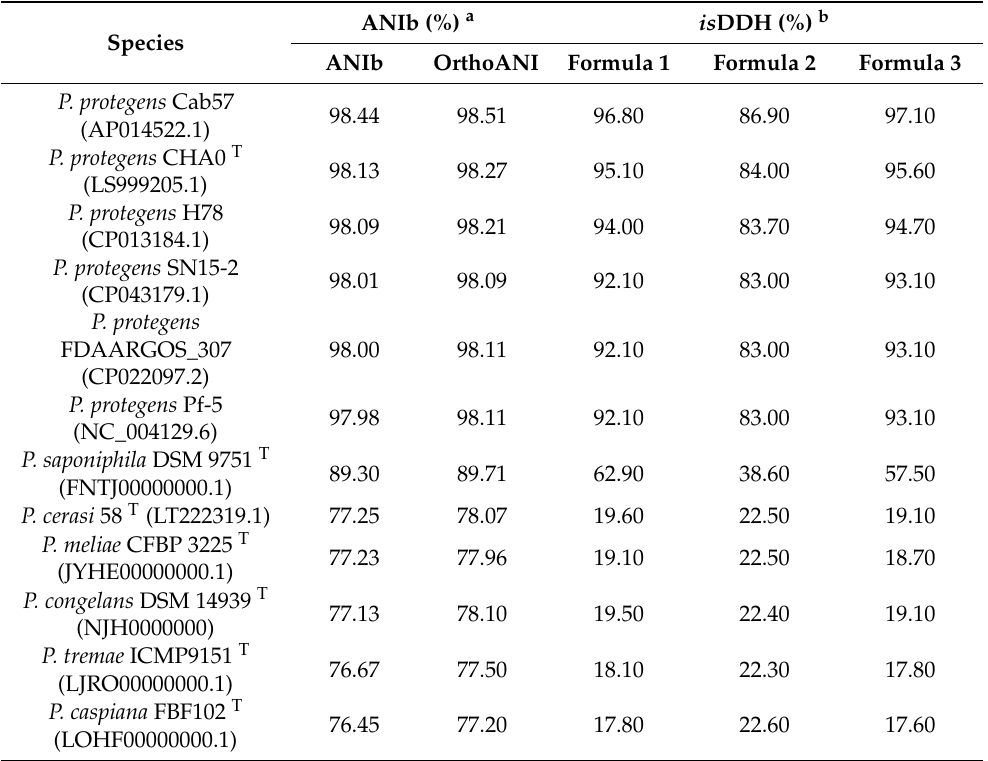
Table 2. Average nucleotide identity (ANI) and in silico DNA-DNA hybridization ( is DDH) values between the genome sequence of strain FJKB0103 and closely related Pseudomonas species. ANIb (%) a is DDH (%) b Species ANIb OrthoANI Formula 1 Formula 2 Formula